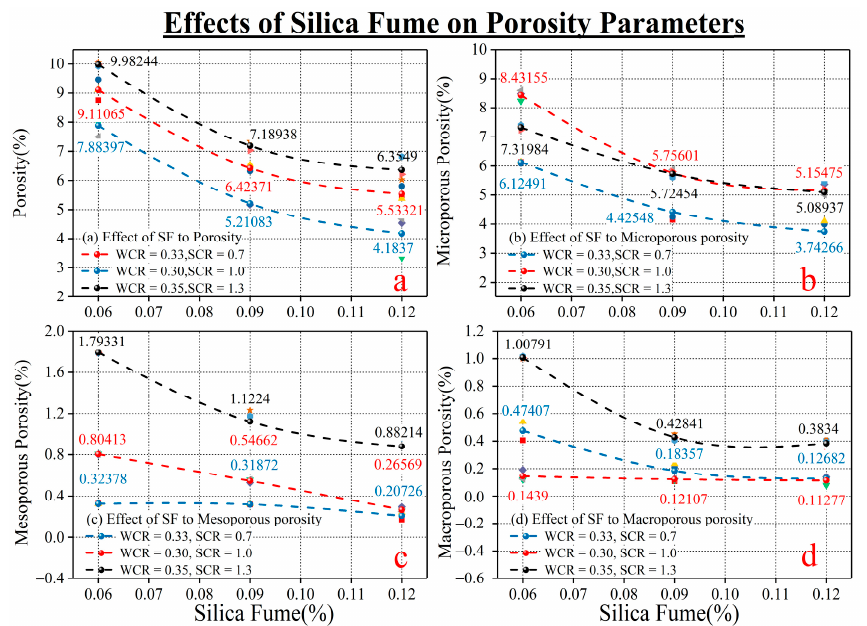
Figure 4. The influence of SF on porosities of different radii. ( a ) is the influence of SF on the porosity. ( b ) is the influence of SF on the microporosity. ( c ) is the influence of SF on the mesoporosity. ( d ) is the influence of SF on the microporosity. Table 5. The reduction rate of different types of porosity.